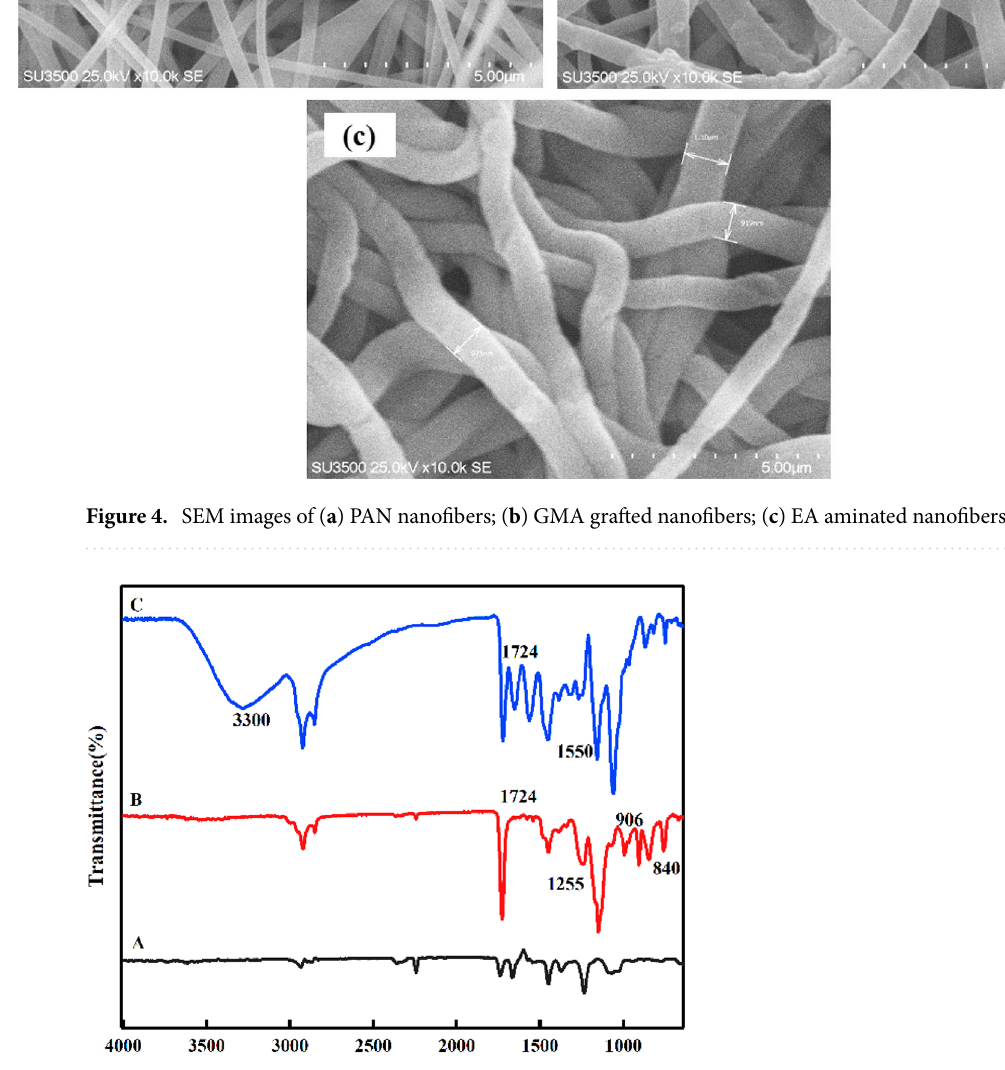
Figure 5. FTIR Spectra of ( A ) PAN nanofibers; ( B ) GMA grafted nanofibers and ( C ) EA aminated nanofibers with